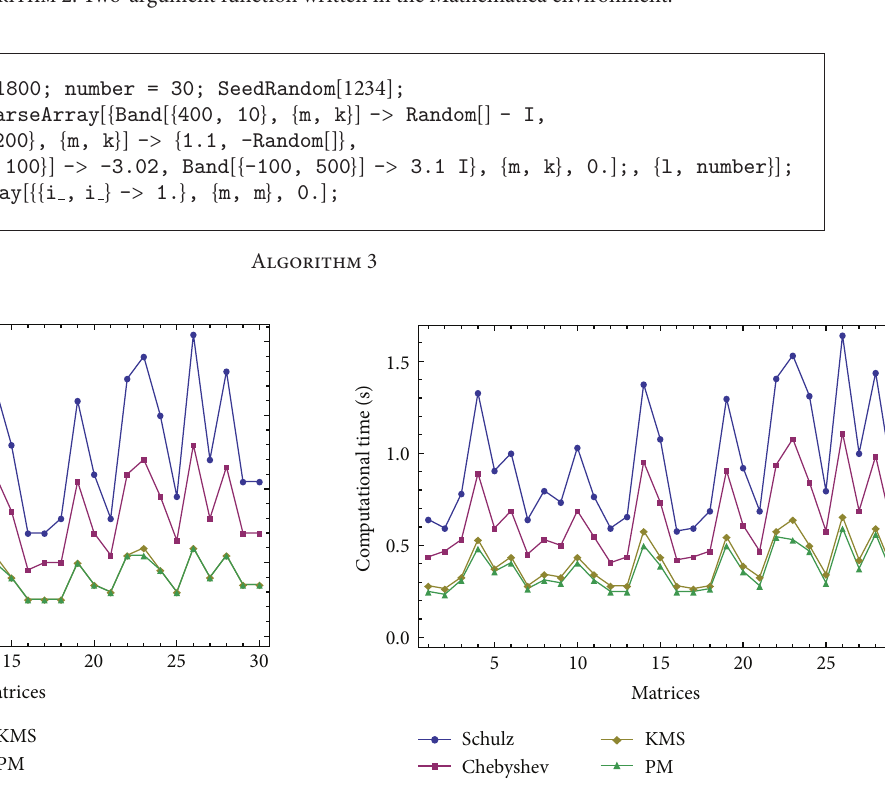
Figure 1: The results of comparisons for Experiment 1 in terms of the number of iterations.